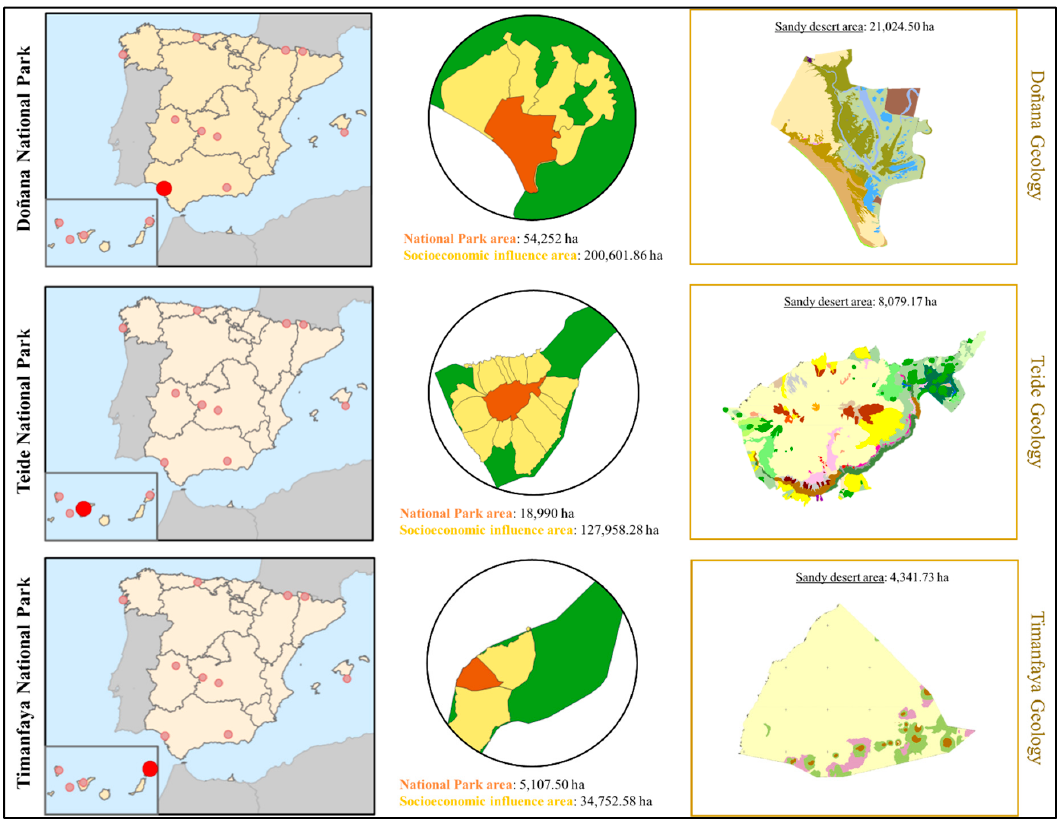
Figure 1. Quantum Geographical Information System (QGIS) maps displaying geographical location, surface, and geology of Doñana, Teide, and Timanfaya National Parks. Sandy desert area’s extension within each National Park is light-yellow colored.